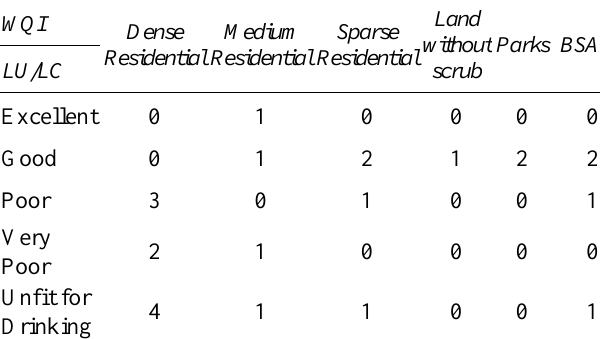
Table 4: Correlation of Water Quality with LU/LC